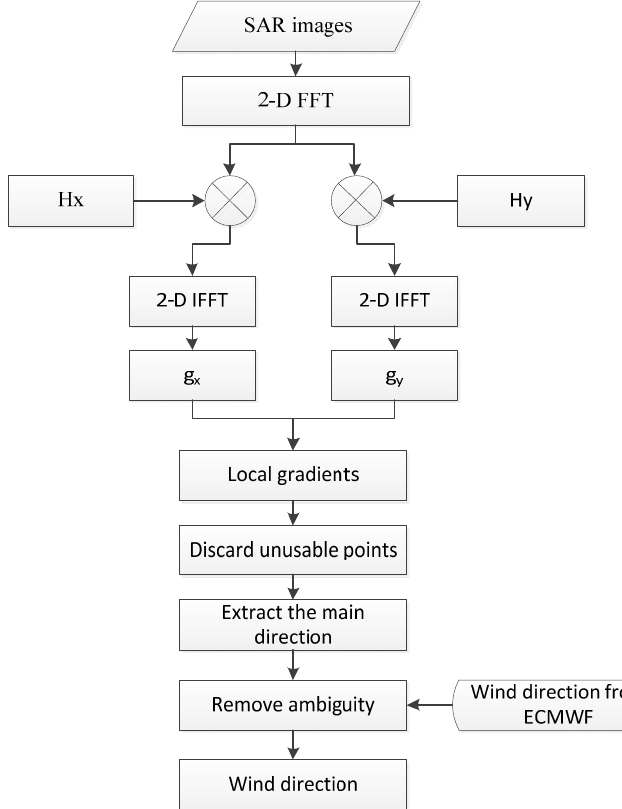
Figure 1. Flowchart of the improved local gradients method for wind direction retrieval.